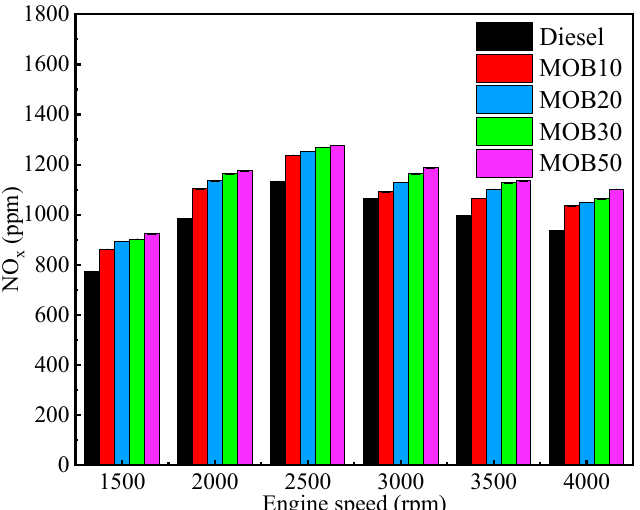
Figure 28. NO x emissions comparison of MOB biodiesel blends and diesel at different engine speeds